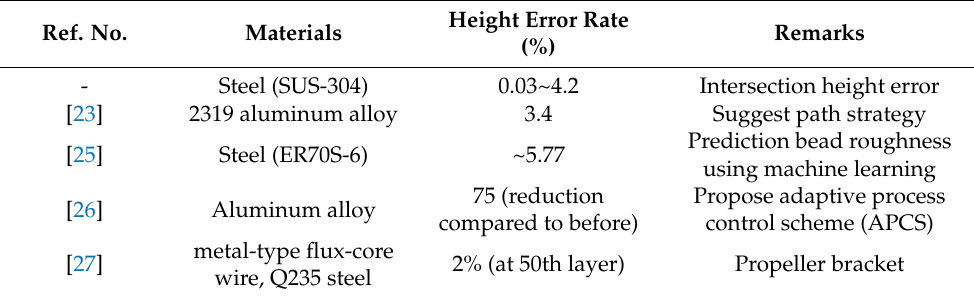
Table 3. Comparison of height error reduction rate with other studies in WAAM. Ref.